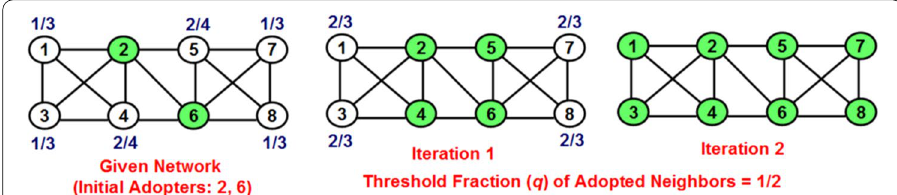
Fig. 1 Execution of the iterative information cascade algorithm for a given set of initial adopters and the threshold fraction ( q ) of adopted